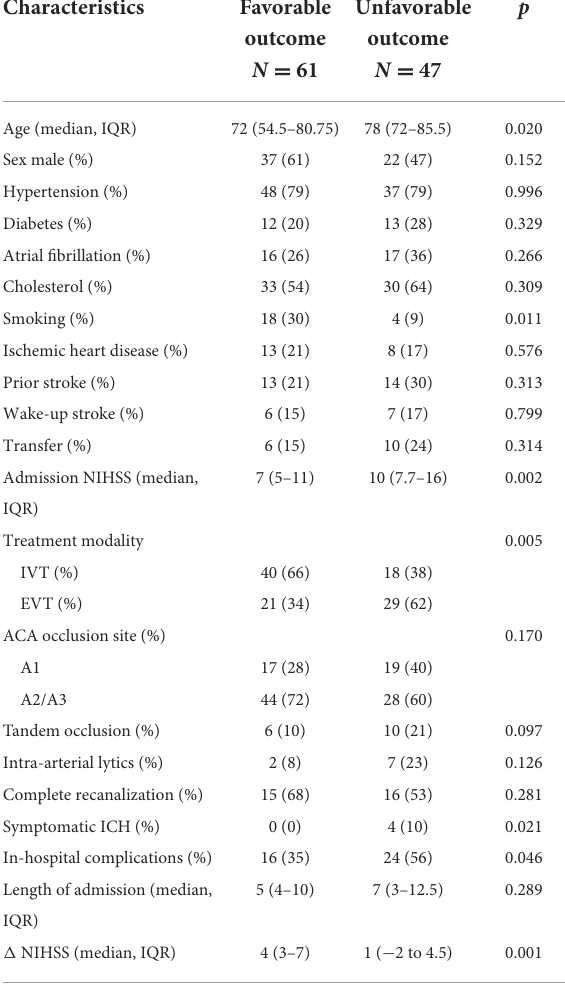
TABLE 2 Outcomes in patients with ACA stroke and tandem occlusions.